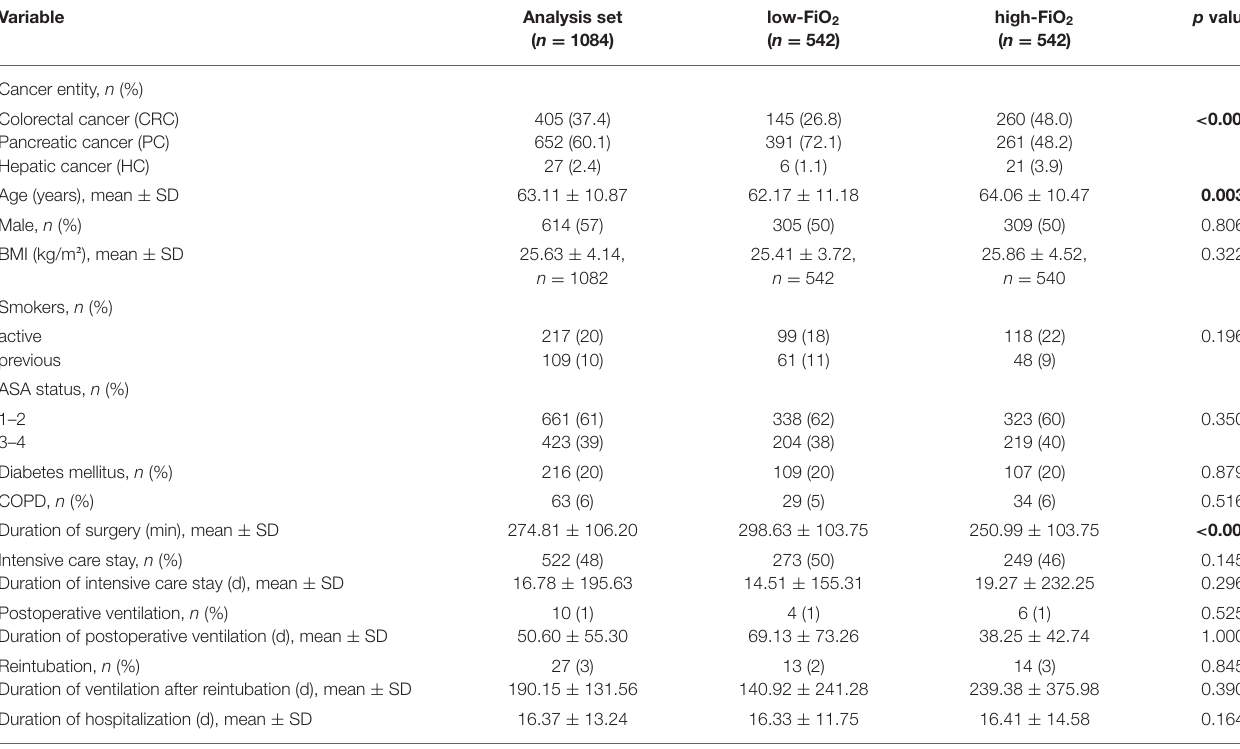
TABLE 1 | Clinical baseline characteristics of the study cohort. Variable